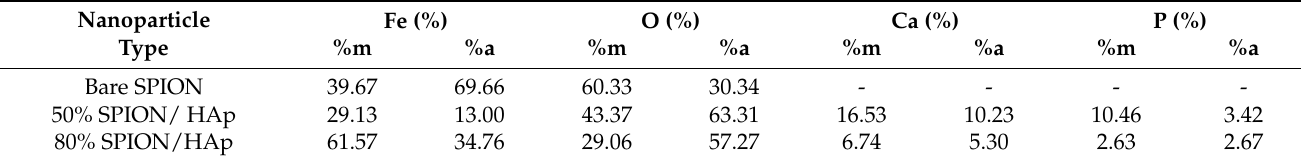
Table 1. EDS result of SPIONs and SPION/HAp